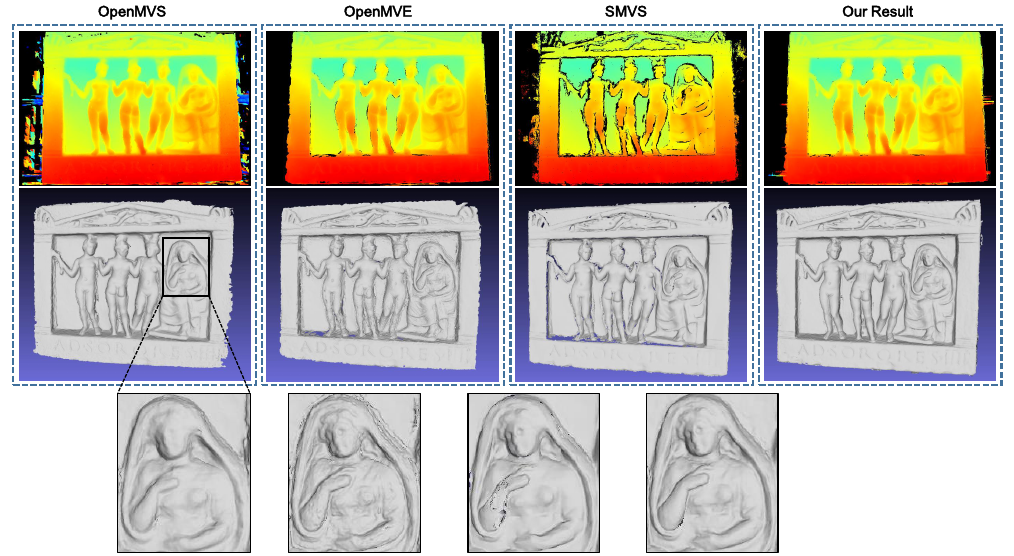
Figure 8. Results on the Relief dataset. From left to right are the output results from OpenMVS, OpenMVE, SMVS and the proposed method. The top row displays the optimized depth map for the fourth view, and the middle the reconstructed 3D mesh models and in the bottom are zoomed-in